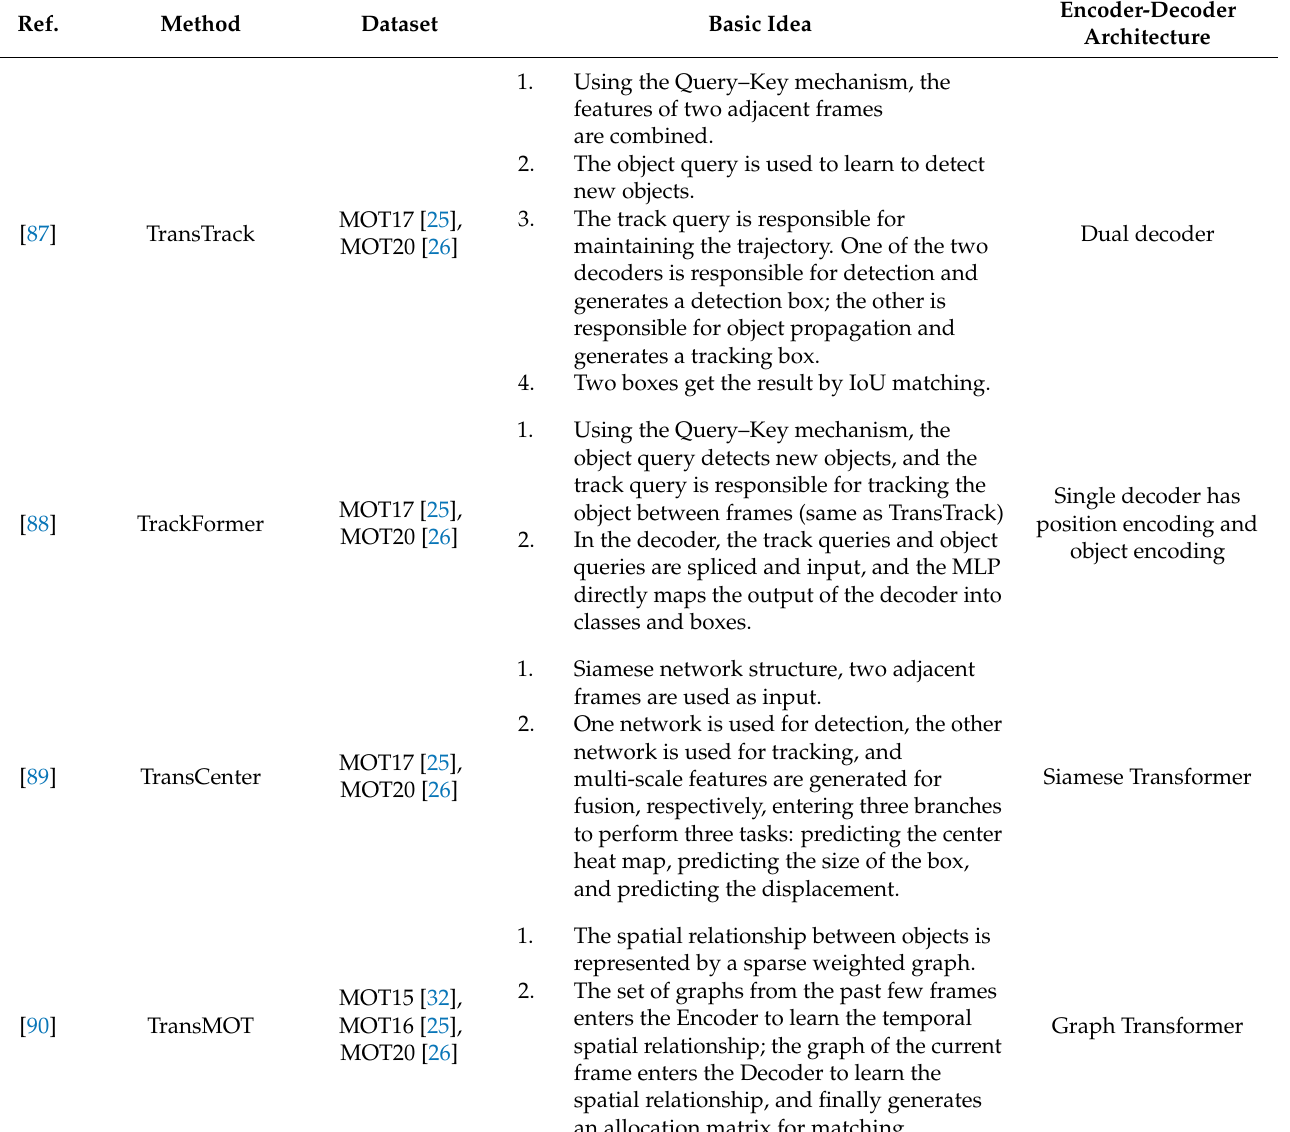
Table 7. Algorithm analysis and comparison based on transformer-based framework.